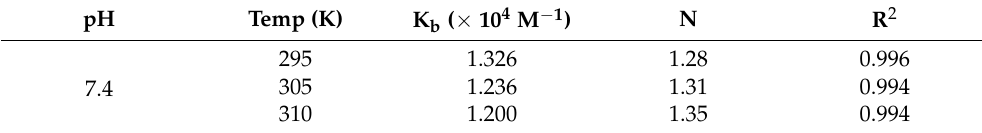
Table 2. The binding constant values and the number of binding sites for the interaction of QTP with HSA. pH Temp